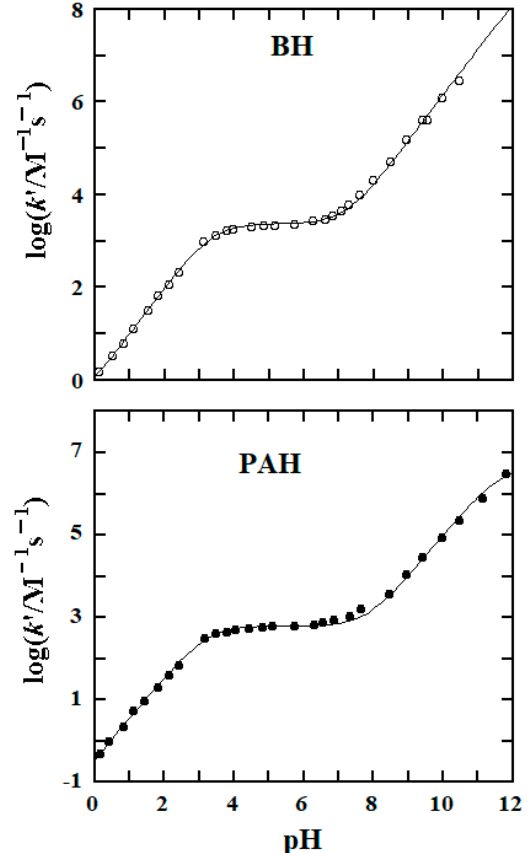
Figure 4. The log k (cid:48) versus pH profiles at 25.0 ◦ C plotted from the data points for the oxidations of BH and PAH by [IrCl 6 ] 2 − (data points from Table S1 in Supplementary Materials). The solid curves were generated from the best fits of Equation (5) to the experimental data by a weighted nonlinear least-squares